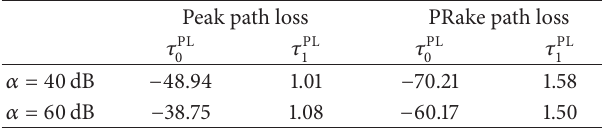
Table 6: Statistical values for the delay spread in terms of the threshold level ( 𝛼